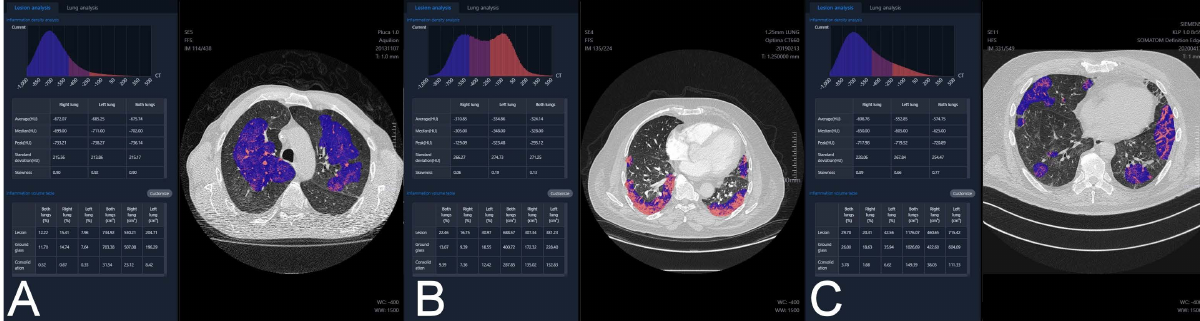
Figure 1. The examples of analysis of ( A ) atypical pneumonia, ( B ) bronchopneumonia and ( C ) COVID-19